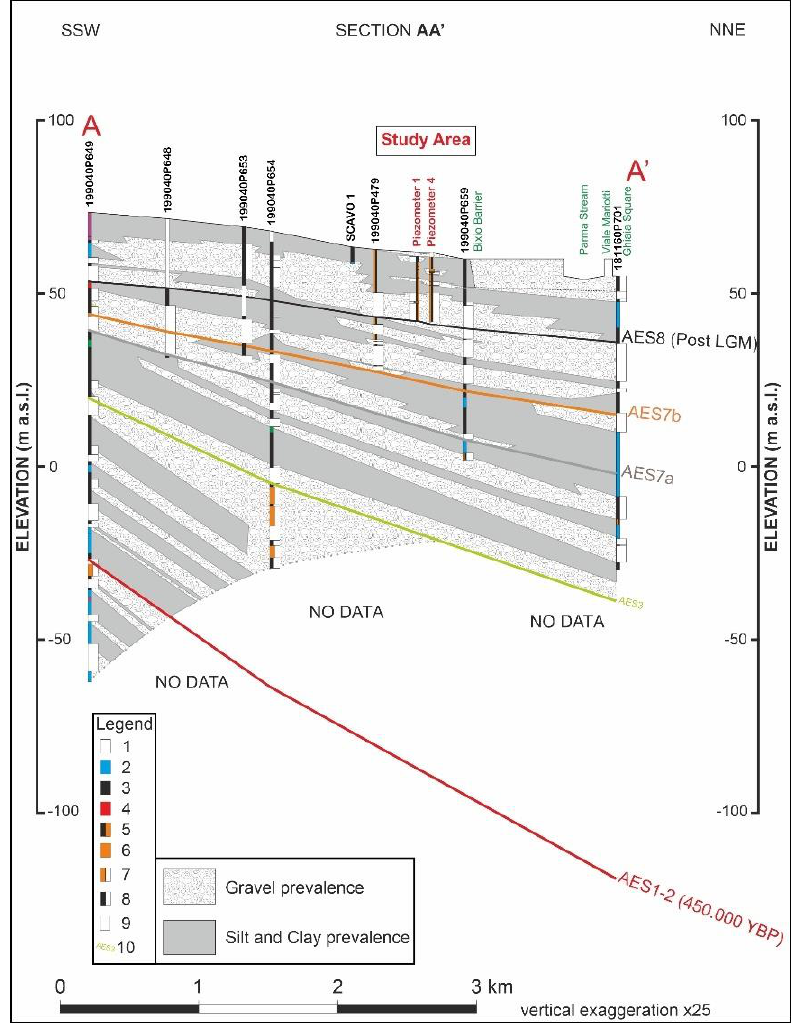
Figure 2. Geological section at basin scale (the trace is shown in Figure 1): (1) fill material, (2) grey/light blue clay and silt; (3) yellow/brown clay and silt; (4) red clay and silt; (5) silt; (6) sand; (7) gravel and sand; (8) gravel and clay/silt; (9) gravel; (10) Code of Geological Unit [ sensu 37]: AES1: